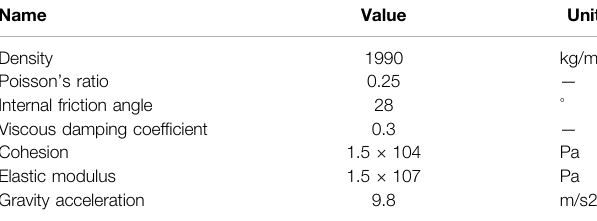
TABLE 1 | List of simulated particulate material parameters.